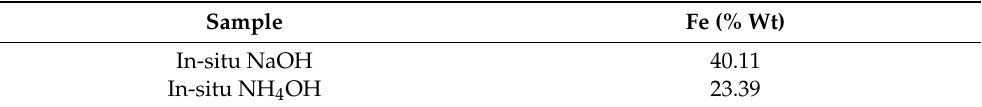
Figure 4. Diffractogram XRD analysis of ( A ) magnetic jabon wood after in-situ treatment with NaOH precursor (blue line); ( B ) magnetic jabon wood after treatment with NH 4 OH precursor (red line), and ( C ) untreated jabon wood (black line).